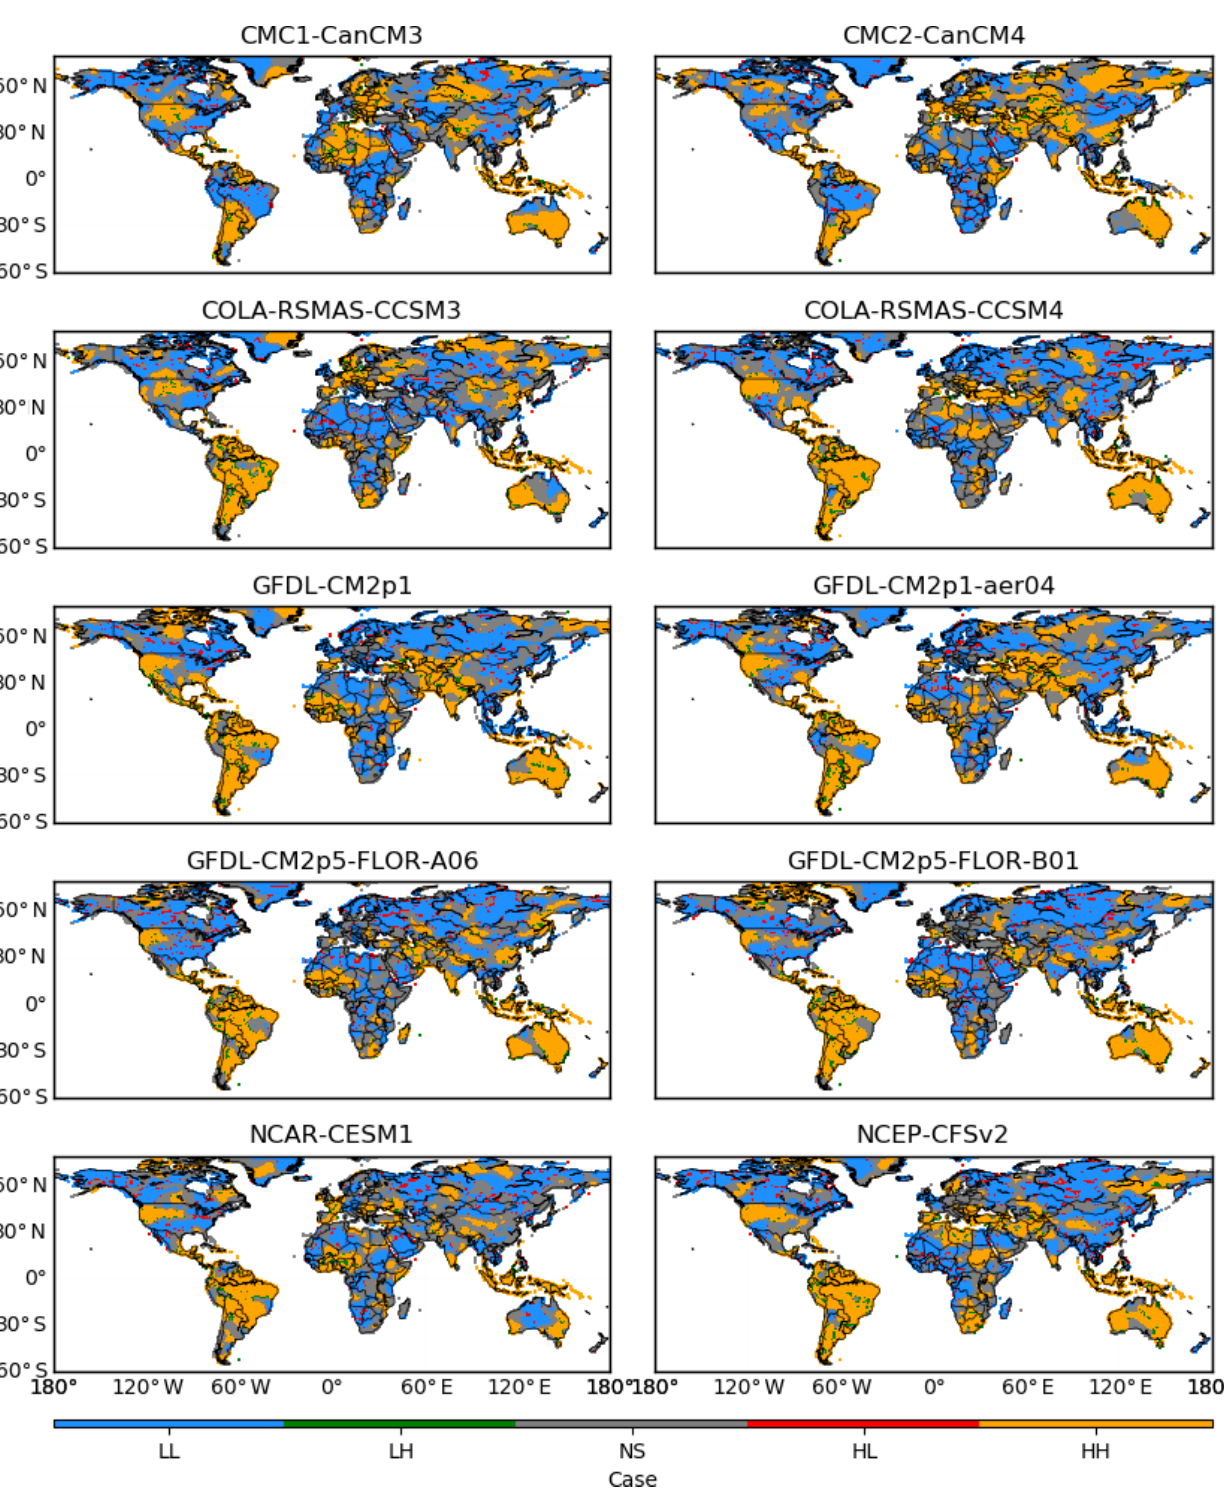
Figure 3. Classification of grid cells across the globe into five cases based on spatial clustering of anomaly correlation. Case HH is marked in orange, case HL in red, case NS in grey, case LH in green, and case LL in blue. H and L are respectively short for high and low; case HH (HL, LH, and LL) indicates that a grid cell with high (high, low, and low) anomaly correlation is surrounded by grid cells with high (low, high, and low) anomaly correlation. NS is short for not significant; case NS means that the anomaly correlation at a grid cell or surrounding grid cells is